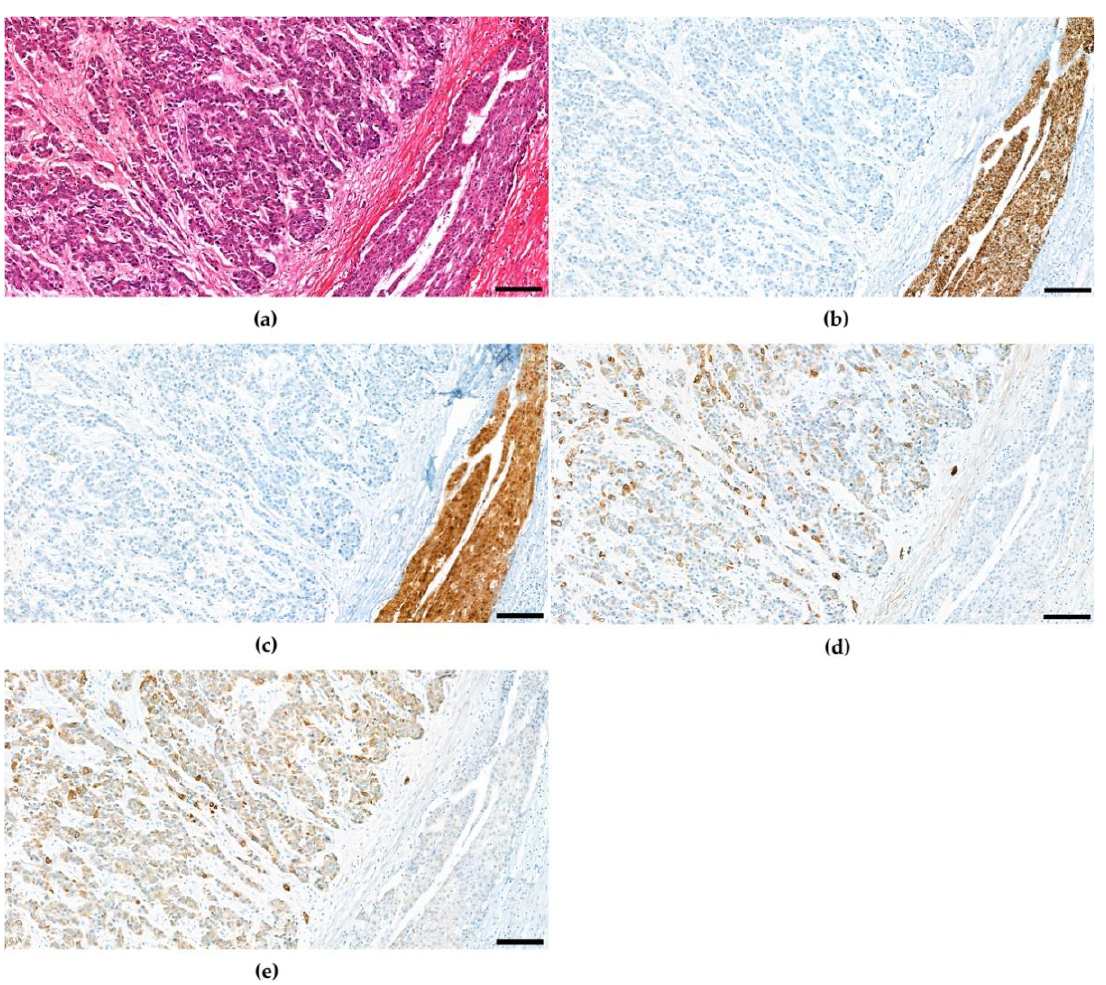
Figure 4. Combined hepatocellular and cholangiocellular carcinoma in a 55-year-old male patient. ( a ) H&E ( b ) HepPar1, ( c ) Arginase-1 ( d ) CK7 ( e ) CK19. CD56 and c-Kit were not expressed. Scale bar: 100 µm.